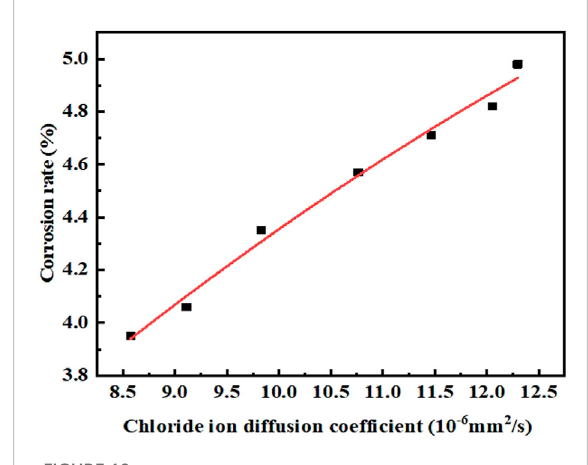
FIGURE 10 Fitted curves between chloride ion diffusion coef fi cient and steel rebar corrosion